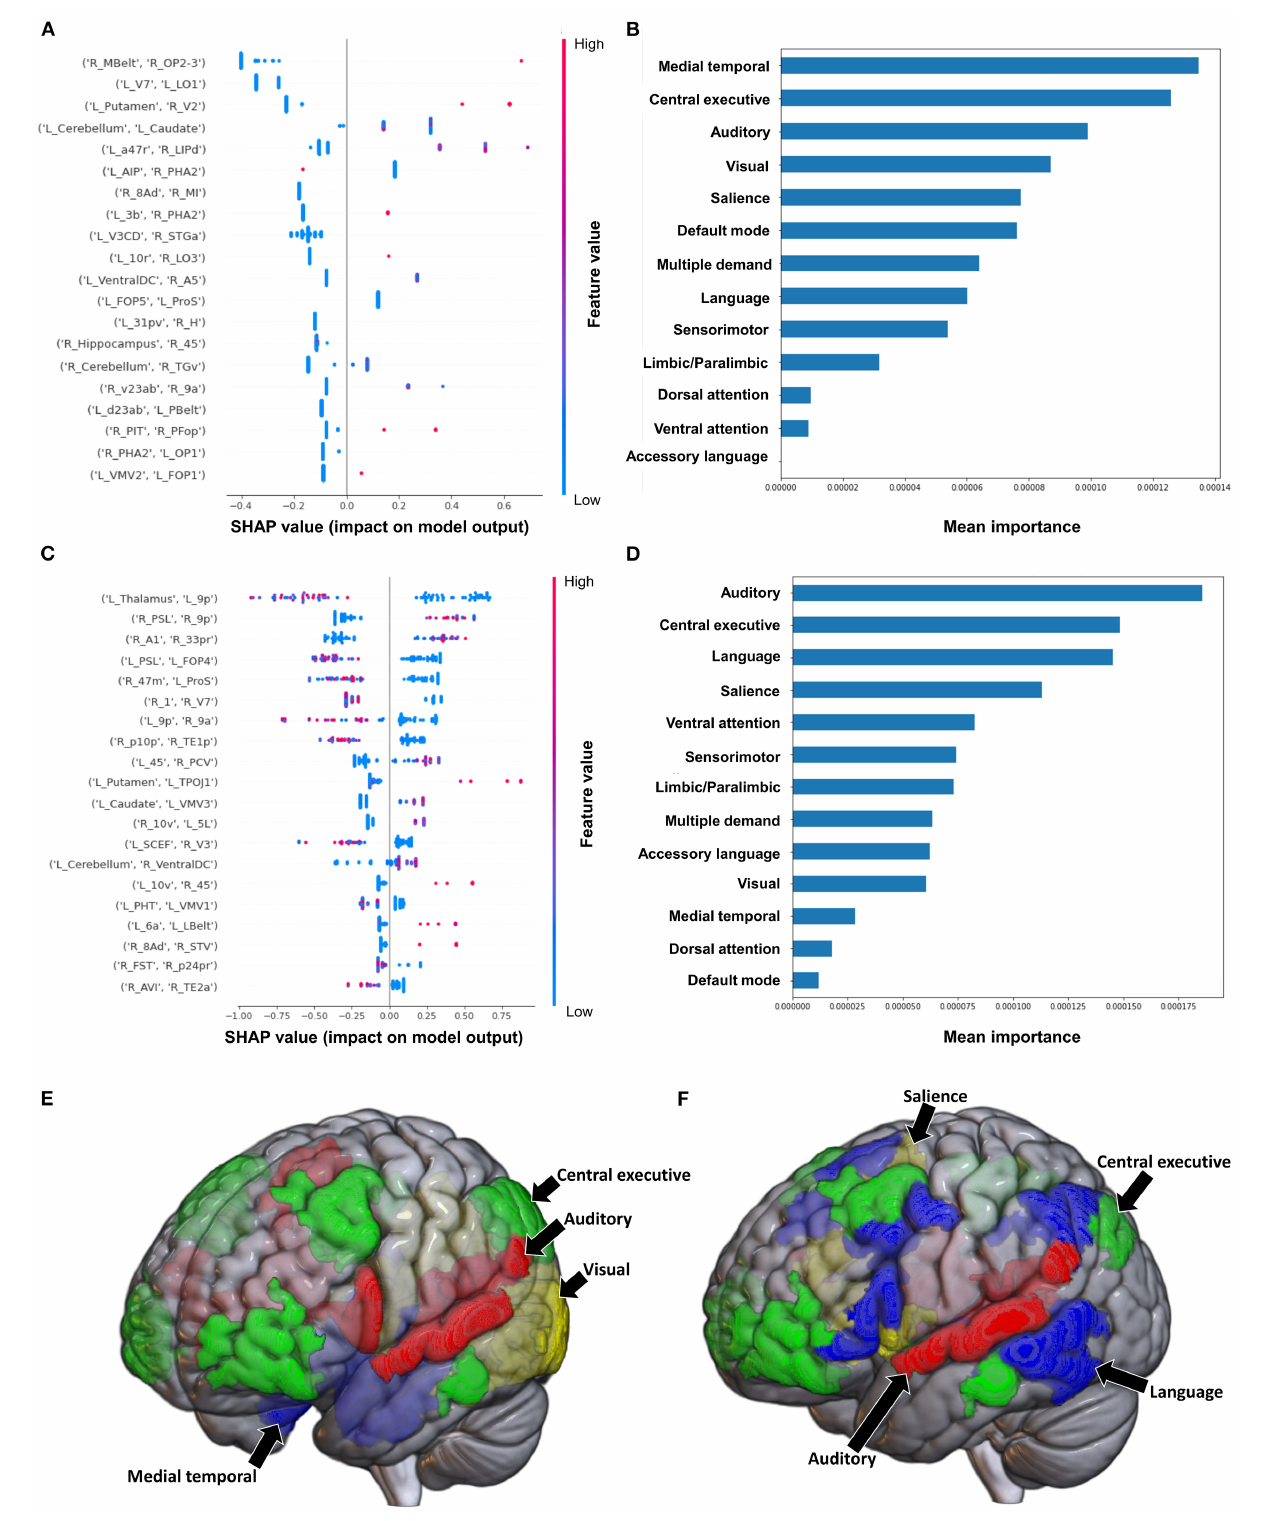
FIGURE4 Feature Importance Analysis of the models classifying the modified Ashworth scale—lower extremity based on functional connectivity at the (A) individual brain region level, and (B) the network level; and based on structural connectivity at the (C) the individual brain region level, and (D) the network level. The networks contributing most to the models’ classifications, based on (E) functional connectivity, and (F) structural connectivity, have also been visualized on brain